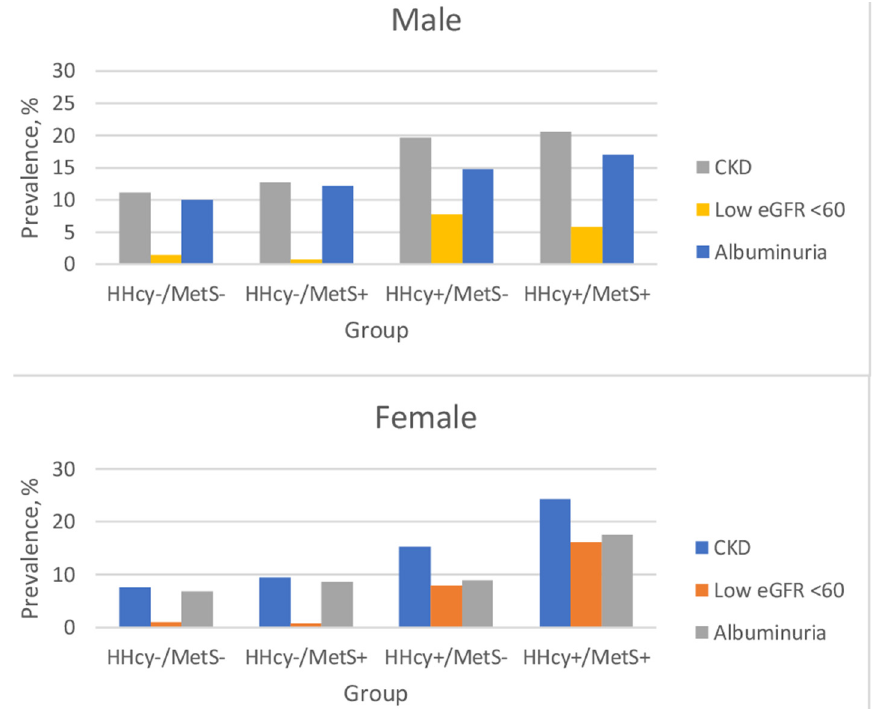
Figure 1. Prevalence of CKD among the four groups. Abbreviations: HHcy, hyperhomocysteinemia; MetS, metabolic syndrome; CKD, chronic kidney disease; eGFR, estimated glomerular filtration rate.